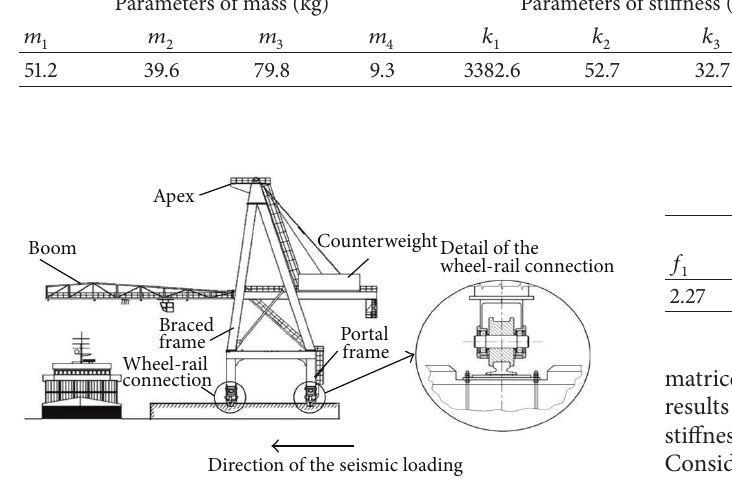
Figure5:Schematicmodelofthecranewiththedirectionofseismic loading.